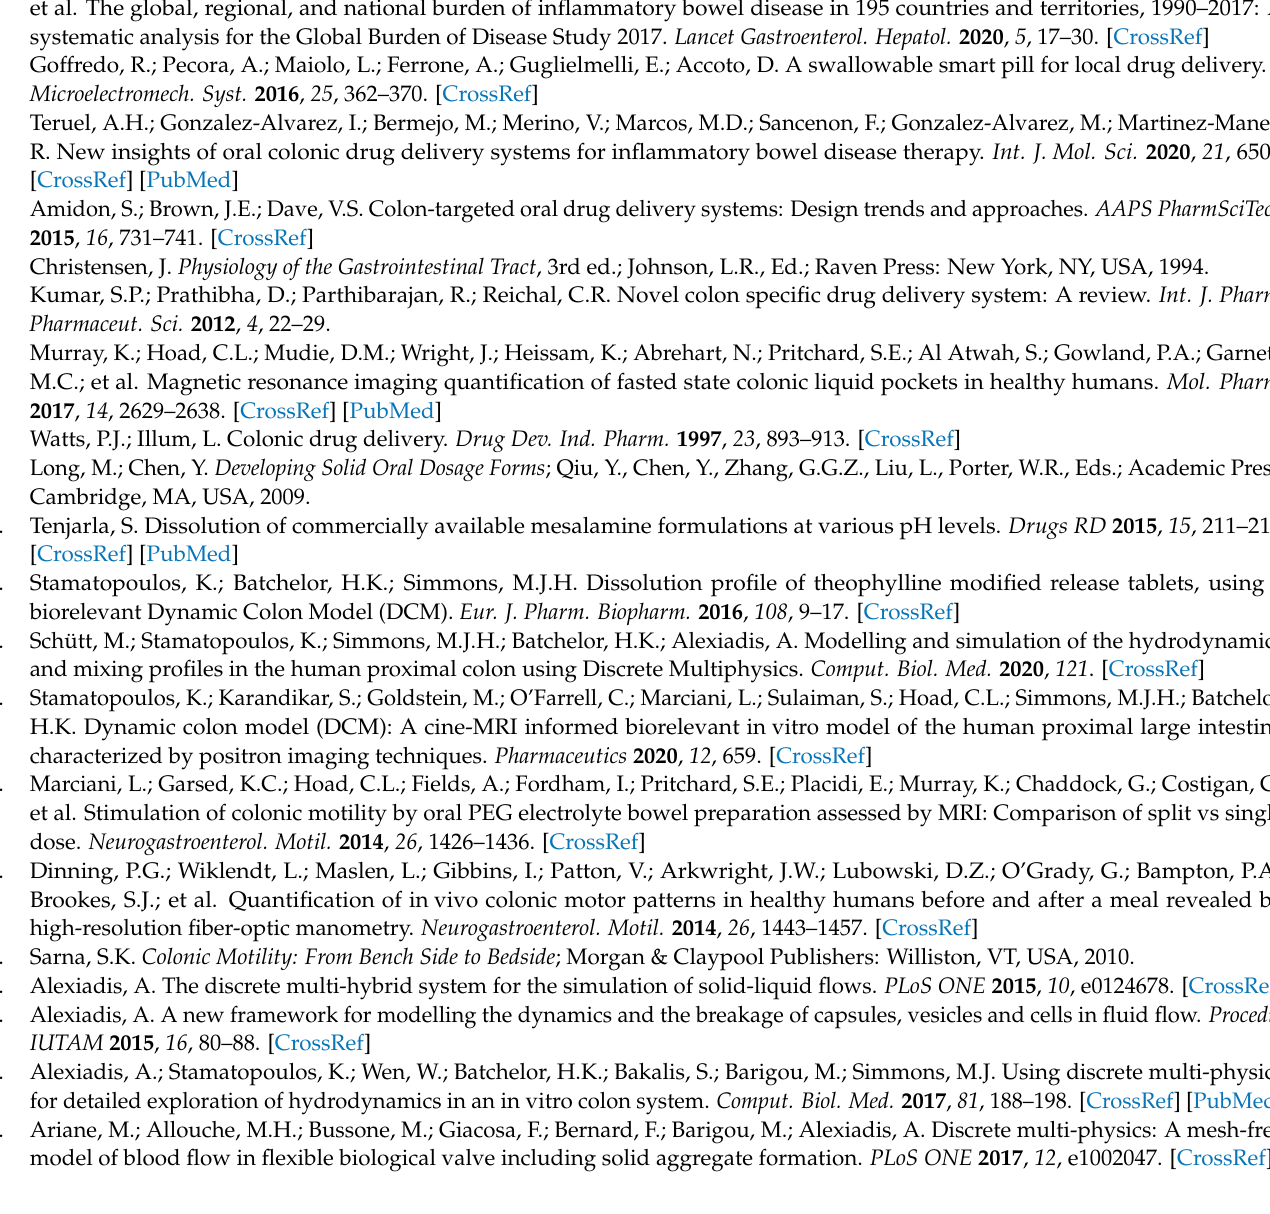
Table A2 shows a possible way to combine the nine dimensional variables into six dimensionless parameters. As we can see, fixed the radius R , the dimensionless time Π 1 is proportional to the diffusivity, which justify the use of